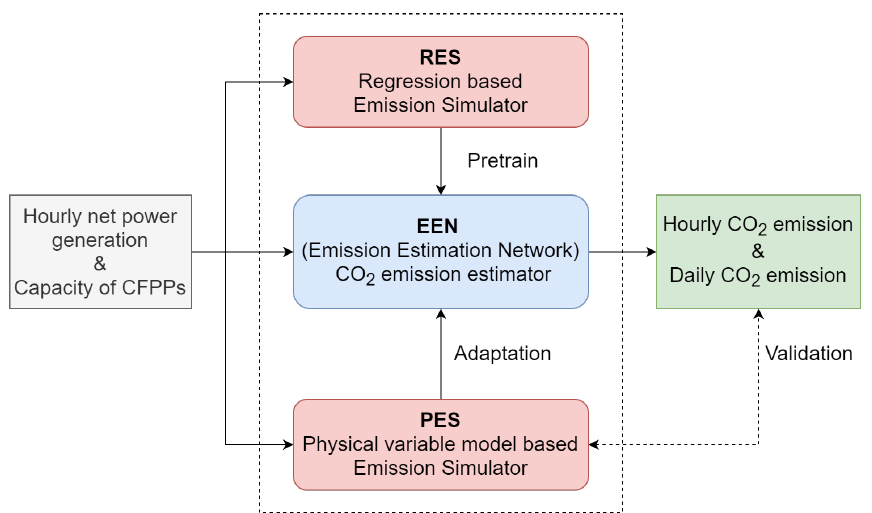
Figure 9. The architecture of the proposal.